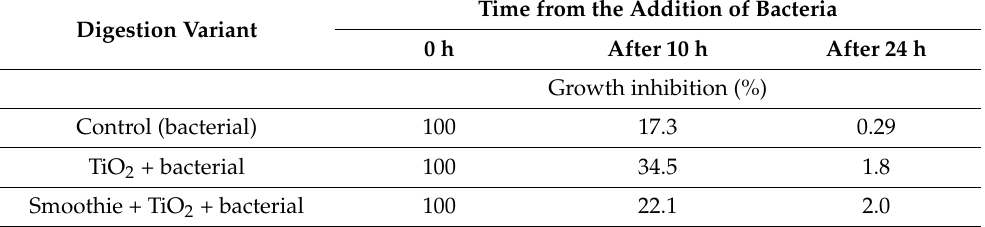
Figure 2. Content of Ti ions (mg/L) at the respective stages of in vitro digestion in the presence of the food matrix (smoothie + TiO 2 ) and the digestive liquid alone (TiO 2 ), n = 3. Various small letters (a, b) mean significant differences at p < 0.05. Table 1. Inhibition of L. plantarum growth in the in vitro “gastrointestinal tract” model in the presence of TiO 2